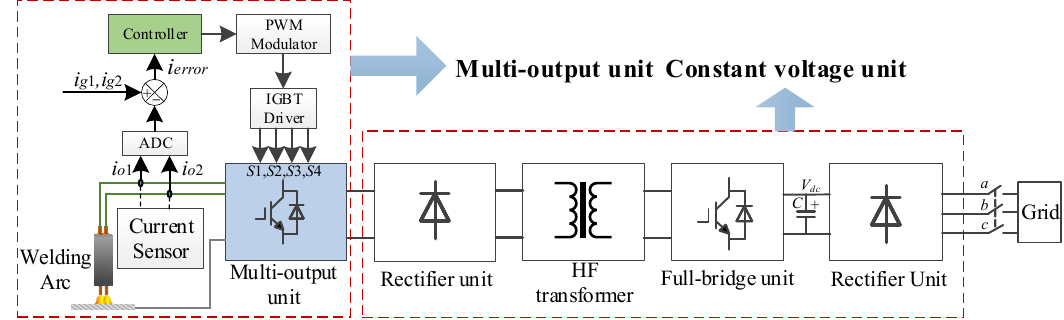
Figure 2. Topology of multi-electrode arc welding power supply.